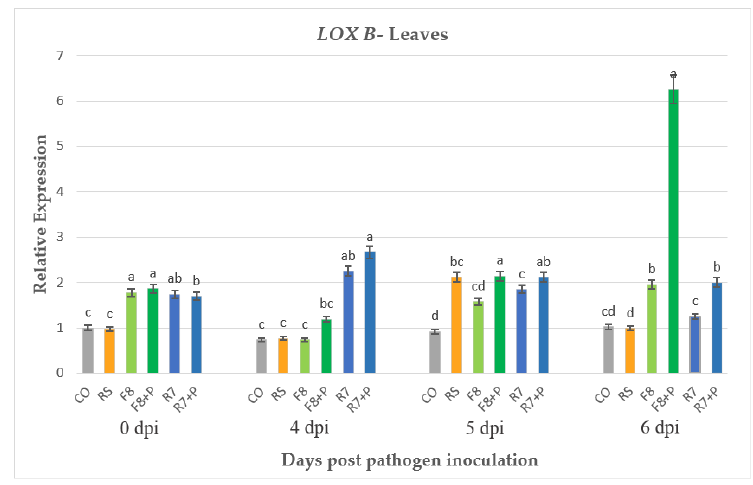
12 of 18 Figure 7. Comparative results of the biological activity of Streptomyces globisporus strain F8 and S. praecox strain R7 against R. solani AG4 on tomato seedlings at the 4th day after pathogen inoculation. ( a ): control treatment; ( b ): plant inoculated with the pathogen alone; ( c , e ): plants inoculated with Streptomyces strains F8 and R7 alone, respectively; ( d , f ): treated seedlings with Streptomyces strains F8 and R7 and pathogen showed smaller lesions than pathogen treatment. Table 4. Mean values of lesion length and width on the crown of the tomato seedlings at the 4th day of pathogen inocula-